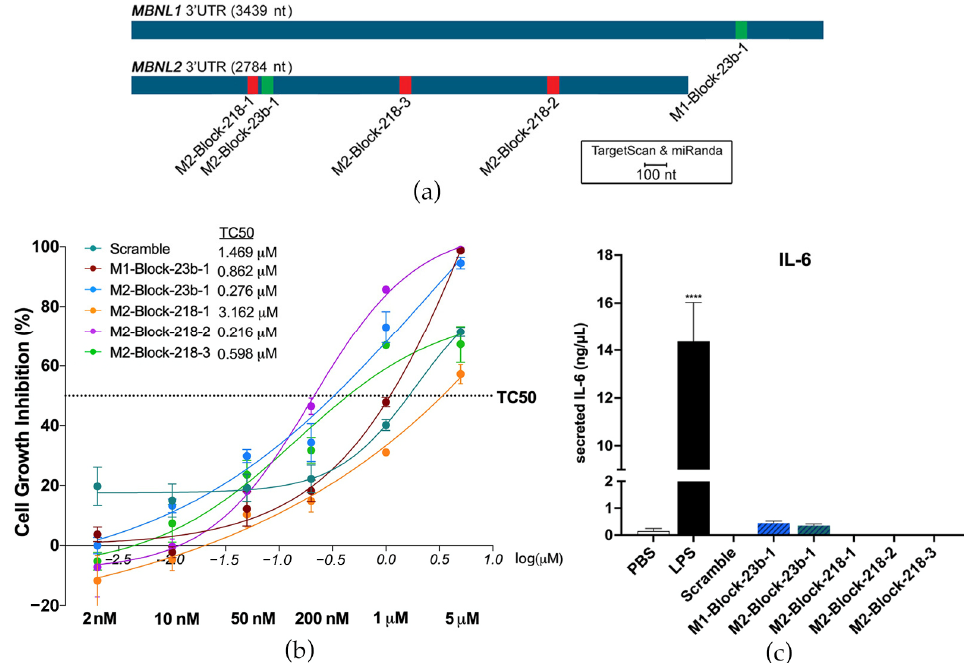
Figure 1. BlockmiRs and their effects on toxicity and immune response. ( a ) miRNA binding sites on MBNL1 and MBNL2 3 ′ -UTRs were predicted using TargetScan and miRanda and confirmed by dual luciferase assay. ( b ) One blockmiR was designed for each confirmed binding site and tested for cell viability at six concentrations (shown underneath the x -axis in bold) in DM1 cells. Data are shown as the average of four technical replicates log-transformed ( x -axis) with the dotted horizontal line showing the threshold concentration at 50% (TC 50 ). The untransformed TC50 for each compound can be seen on the table to the right of the legend. ( c ) Immune activation by blockmiRs in C2C12-derived 3D mouse muscle tissues was determined through IL-6 quantification with three technical replicates. BlockmiRs were all administered at 500 nM. All samples were compared to the Scramble via one-way ANOVA. p -value: p ≤ 0.0001 (****). Error bars = SEM. Reproduced/adapted from [29] Universitat de València, 2022.